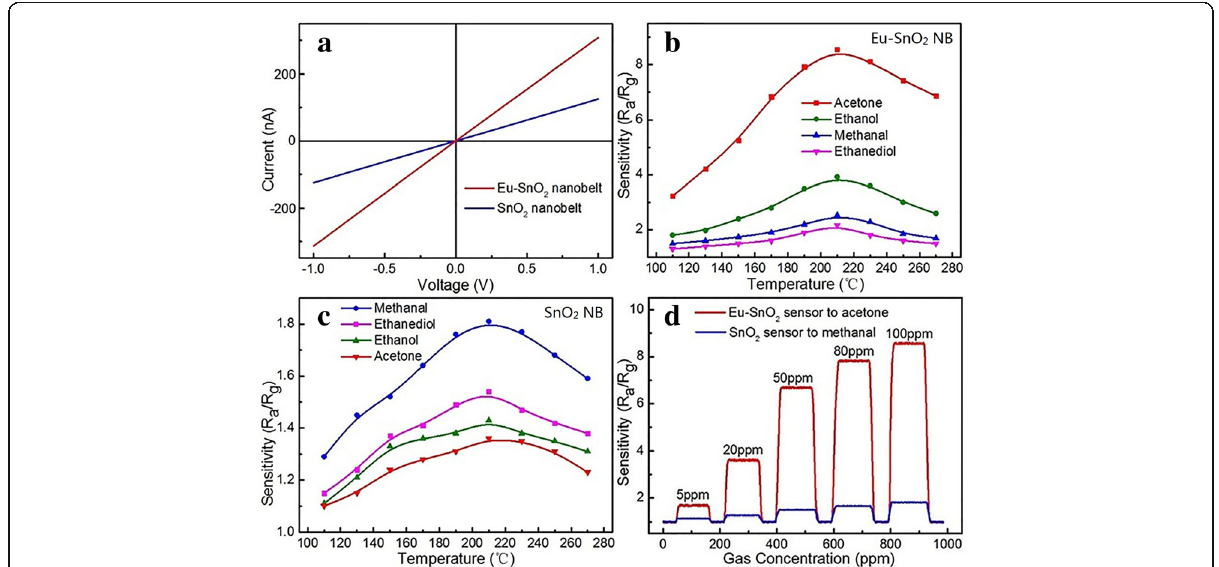
Fig. 5 a I – V curves. b Response versus temperature curves of Eu-SnO 2 NB. c Response versus temperature curves of SnO 2 NB. d Chemical resistance